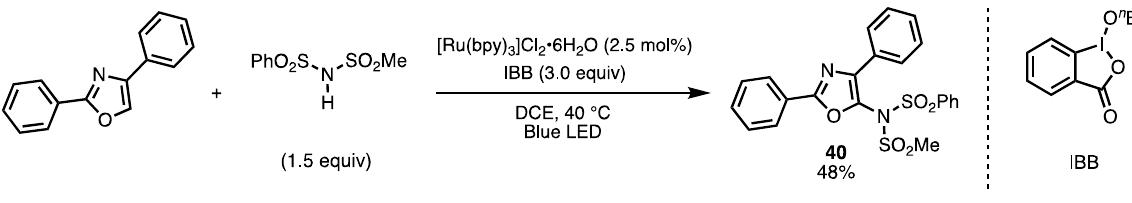
The synthesis of 40 is representative: 2,4-Diphenyloxazole (44 mg, 0.20 mmol), N -(methylsulfonyl)benzenesul- fonamide (71 mg, 0.30 mmol, 1.5 equiv), IBB (192 mg, 0.60 mmol, 3.0 equiv), and [Ru(bpy) 3 ]Cl 2 ·6H 2 O (3.7